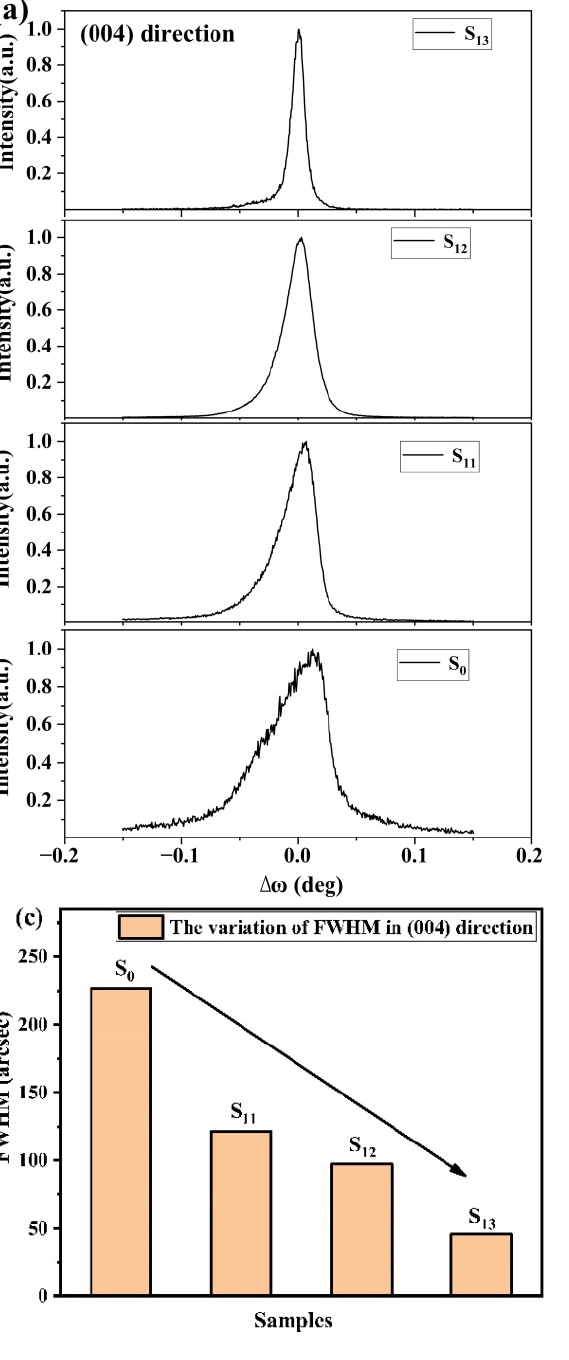
Figure 3. XRD pattern of ω scan in diamond. ( a ) (004) reflection; ( b ) (311) reflection; ( c ) the variation of FWHM in (004); ( d ) the variation of FWHM in (311).